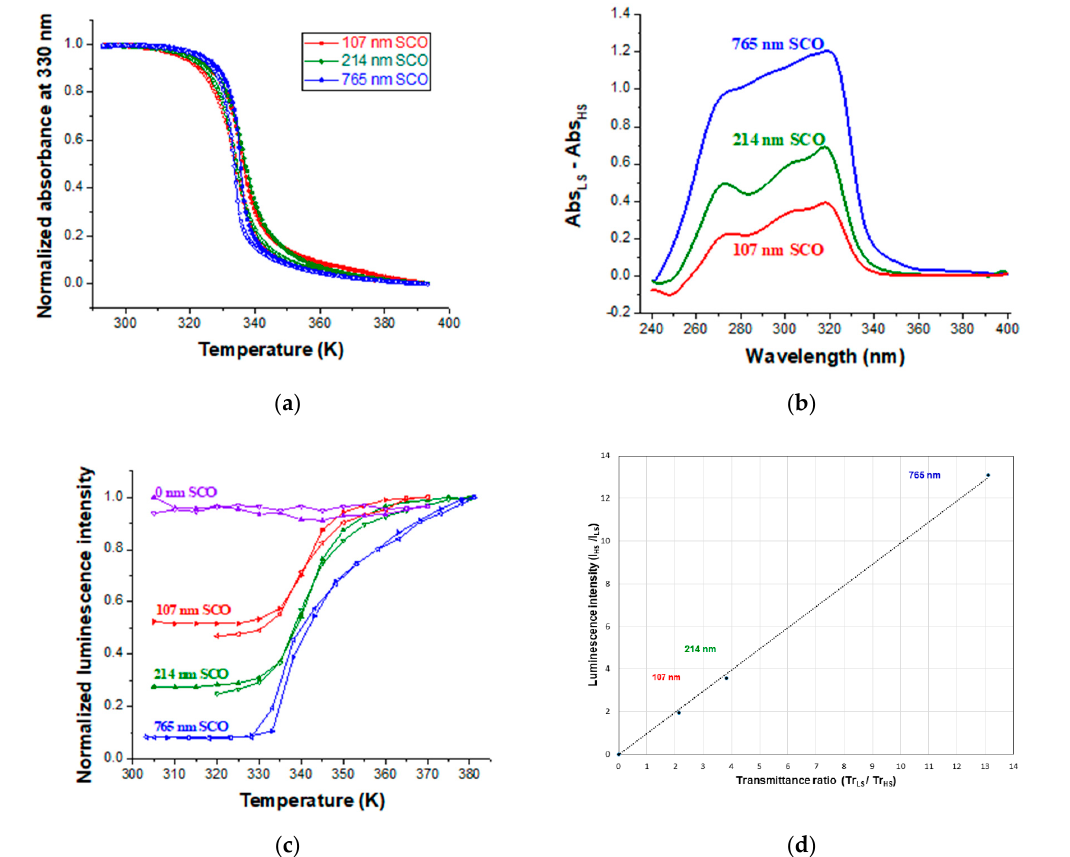
Figure 4. Correlation between the absorbance of [Fe(HB(tz) 3 ) 2 ] and the luminescence of Ir(PPy) 3 . ( a ) Normalized temperature dependence of the UV absorbance (at 330 nm) for three bilayer samples with different SCO layer thicknesses (107, 214 and 765 nm). ( b ) Absorbance changes associated with the SCO for different SCO film thickness. ( c ) Normalized temperature dependence of the luminescence intensity for different SCO film thickness. ( d ) Plot of the luminescence intensity ratio vs. the UV transmittance ratio between the HS and LS states. The corresponding SCO film thickness is also shown.